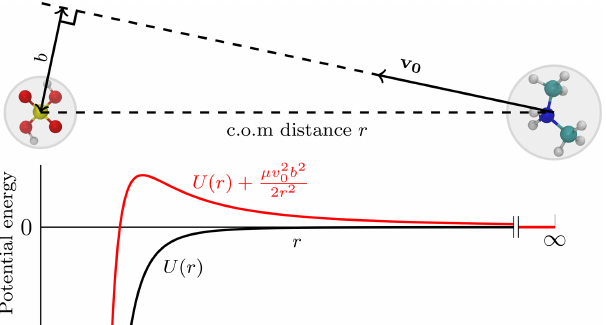
Figure 1. A schematic diagram of the central field approach with the corresponding potential energy profile. The molecule on the left is at rest, and its center of mass (c.o.m.; center of the gray circle) designates the center of the field, while the molecule on the right initially moves along a trajectory set by a velocity vector, v 0 . At the start, the colliding molecules are infinitely far away from each other, and the intermolecular potential energy U ( r ) (black curve) equals zero. The perpendicular distance between the trajectory and the center of the field is the impact parameter b . If b > 0, the orbital angular momentum gives rise to a centrifugal barrier shown by the red